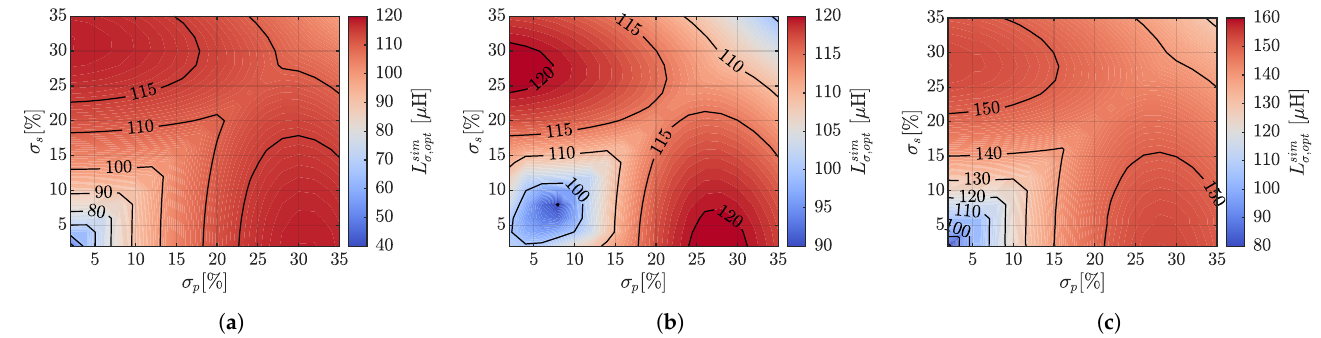
Figure 9. Numerical solution for L σ ,opt with the converter specifications given in Table 1. ( a ) For the 3 φ YY-connected MFT. ( b ) For the 3 φ Y ∆ -connected MFT. ( c ) For the 1 φ